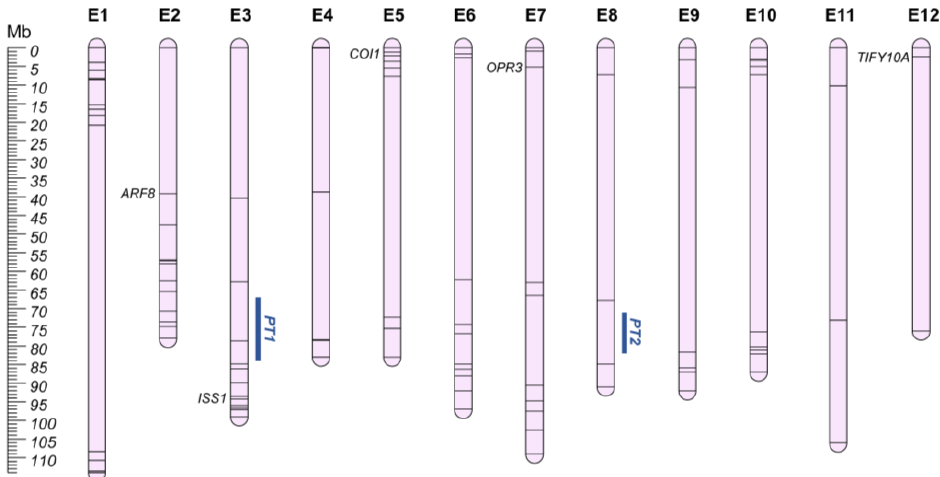
Figure 3. Parthenocarpic QGRs (PT; Orange) and Male Sterility chromosome map (E1 – E12). Main candidate genes are reported in italics, while information about the other candidates (represented by bars on the chromosomes) are shown in Table S3.